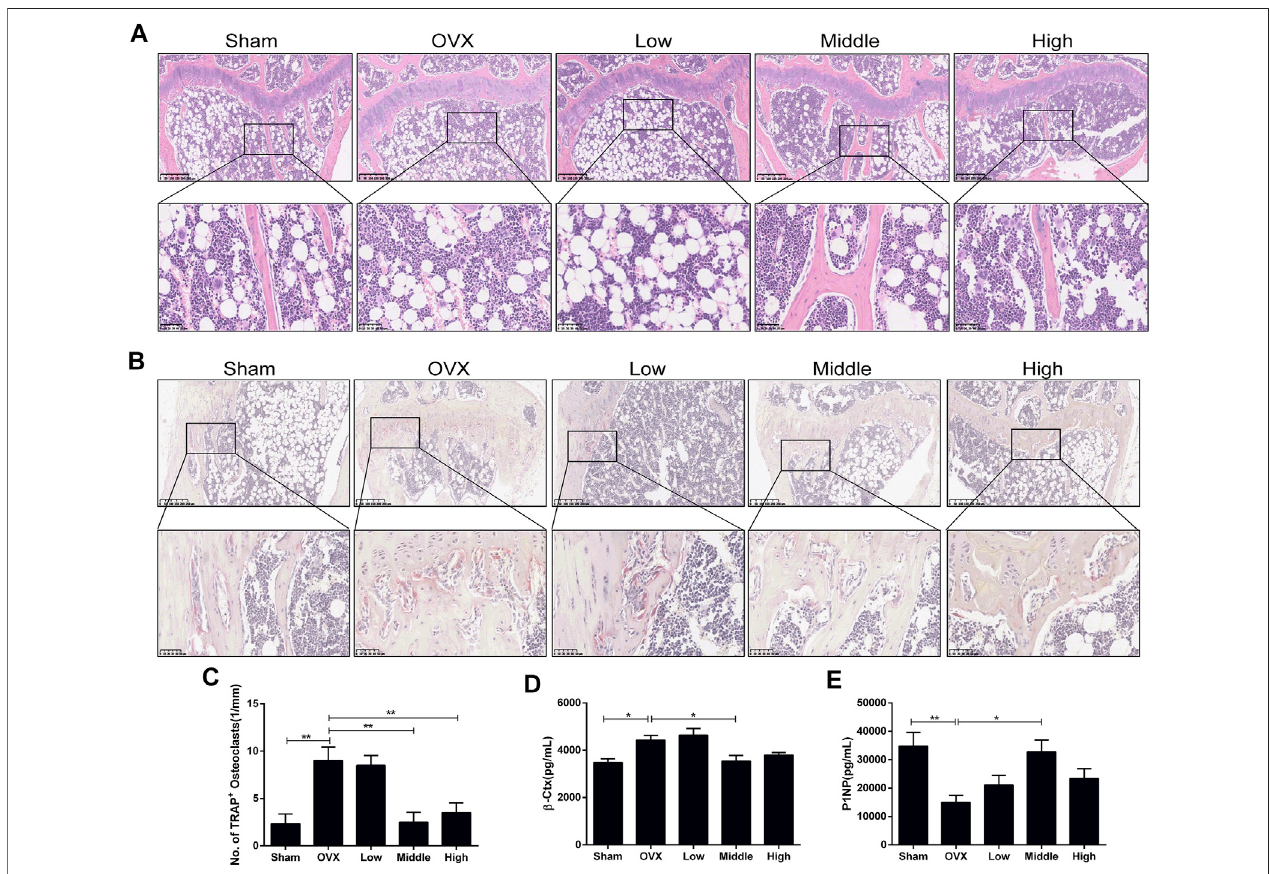
FIGURE 4 | Nitazoxanide protected against OVX-induced trabecular bone loss and osteoclasts formation in vivo. (A) Tibia sections were stained with H&E. n (cid:2) 6. (B) SectionsoftibiaswerestainedwithTRAP. n (cid:2) 6. (C) Thenumberofmultinucleatedosteoclastswascounted. (D – E) Serum β -CtxandP1NPweredetectedbyELISA. n (cid:2) 8. Data are shown as mean ± SD. OVX (cid:2) ovariectomy; TRAP (cid:2) tartrate-resistant acid phosphatase; β -Ctx (cid:2) beta-isomerized C-terminal telopeptides; P1NP (cid:2) procollagen 1 N-terminal propeptide. * p value ＜ 0.05, ** p value ＜